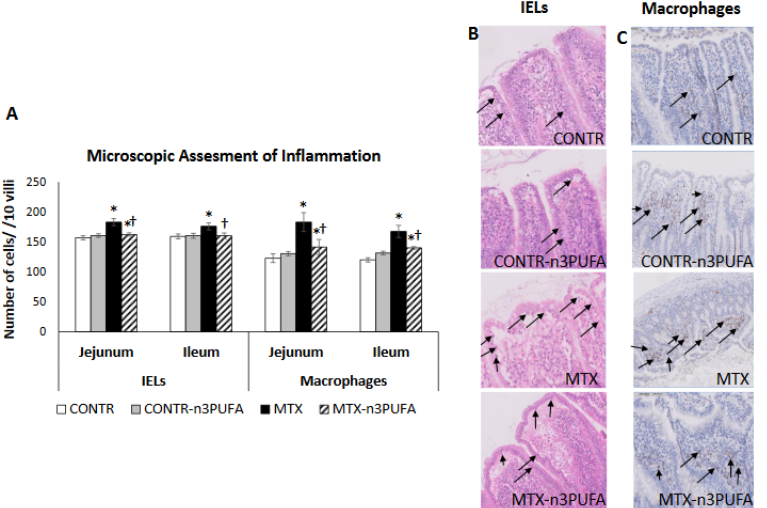
Figure 5. Grade of intestinal inflammation after administration of MTX and treatment with n-3 PUFAs. Immunohistochemistry with CD 68 antibody was performed to identify macrophages ( A , C ). The number of intraepithelial lymphocytes (IELs) was assessed by H&E staining and was calculated per 10 villi ( A , B ). Values are mean ± SEM. CONTR- control, MTX-methotrexate, n-3 PUFAs- n-3 polyunsaturated fatty acids. * p < 0.05 all groups vs. CONTR rats, † p < 0.05 MTX+n-3 PUFAs vs. MTX rats.